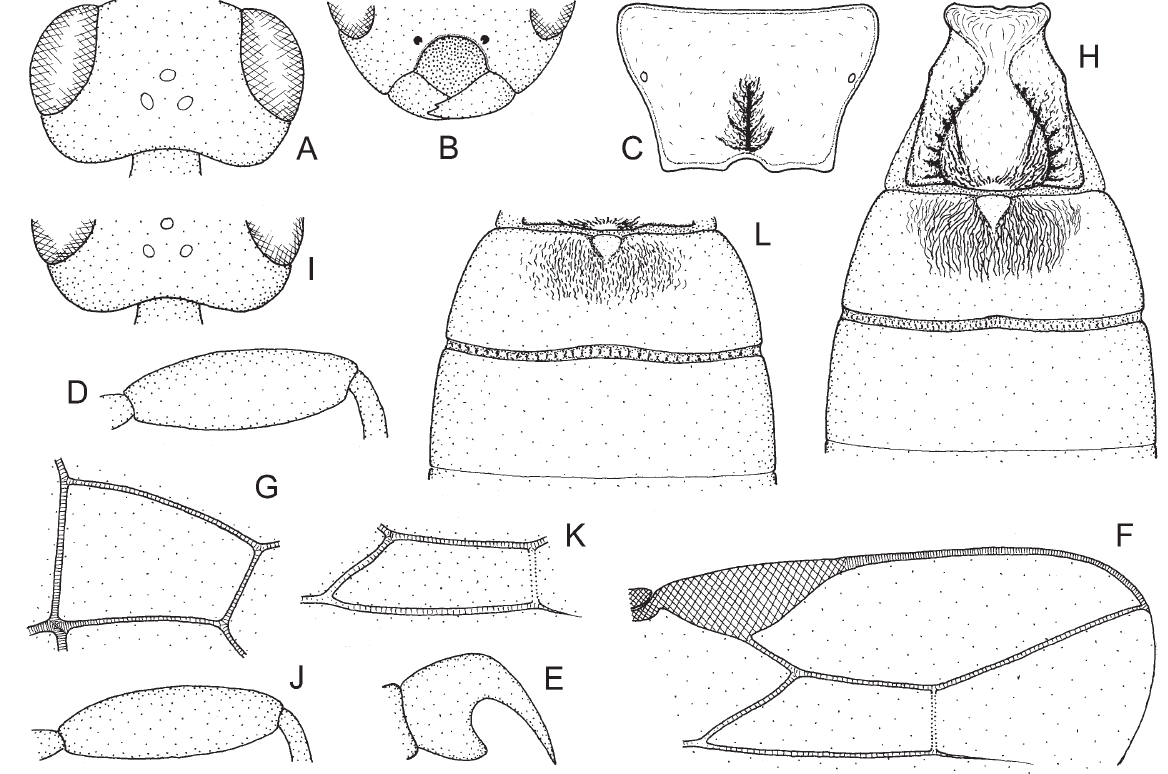
Fig. 51. Bracon ( Glabrobracon ) titubans Wesmael (A-H: ♀ lectotype, I-K: ♀, L: ♀ / ♂). A . Head in dorsal view. B . Head in frontal view. C . Propodeum. D . Hind femur. E . Claw. F . Distal part of right forewing. G . First discal cell of right forewing. H . Tergites 1-3. I . Hind half of head in dorsal view. J . Hind femur. K . Second submarginal cell of right forewing. L . Tergites